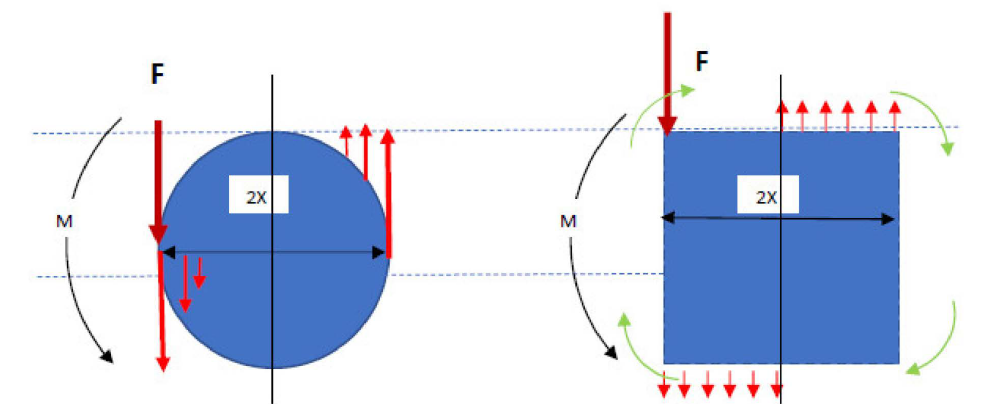
Figure 12. Applied horizontal rotatory force: occlusal view of a cylindrical implant of diameter 2X and a block implant of length 2X: an equal moment M, is generated through an equal force F, applied at an equal distance X from the center of each structure. It is seen that the torsional surface stresses will be more concentrated at the radial tangents of the cylinder compared to the lower, more even distribution of the torsional loads of the flat-faced block (depicted as red arrows). The corners of the block wound also act in opposing resistive directions to the applied moment (green arrows), further reducing the overall peri-implant torsional